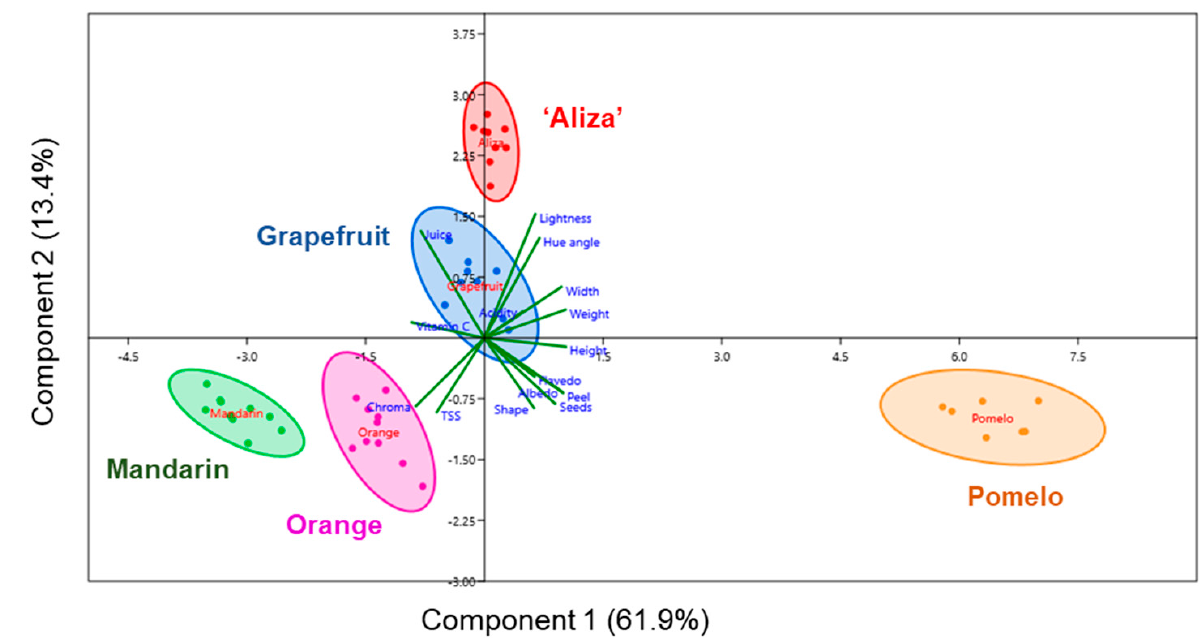
Figure 2. Biplot PCA chart of fruit quality data of ‘Aliza’, grapefruit, pomelo, orange and mandarin. The marked ellipses indicate the 95% probability that a new observation from the same group will fall inside the ellipse.